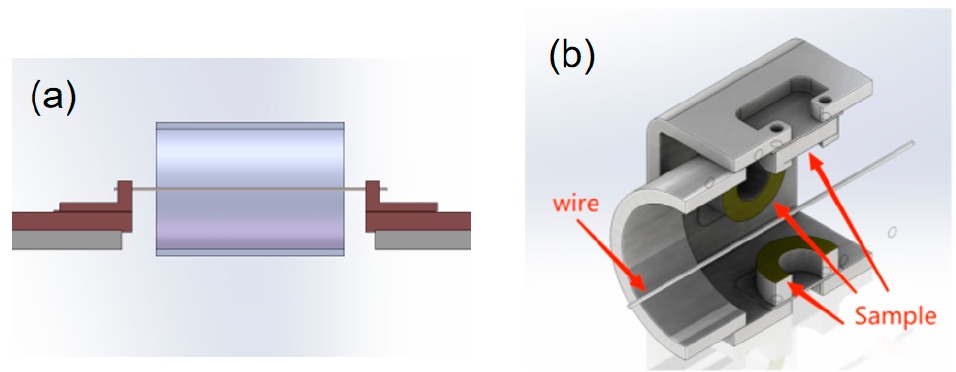
Figure 2. Schematic diagram of the installation methods of the samples: ( a ) sample Ⅰ ; ( b ) samples Ⅱ and Ⅲ .